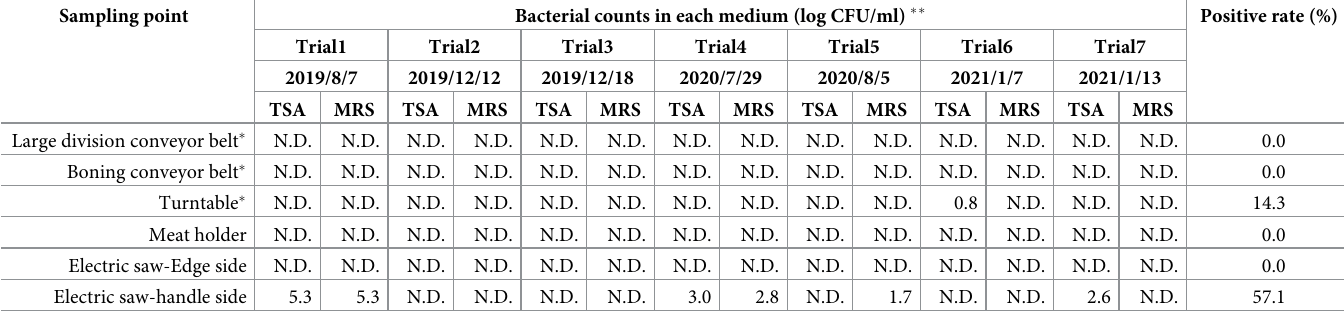
Table 2. The number of psychrophilic microorganisms adhering to equipment used in boning lines. Sampling